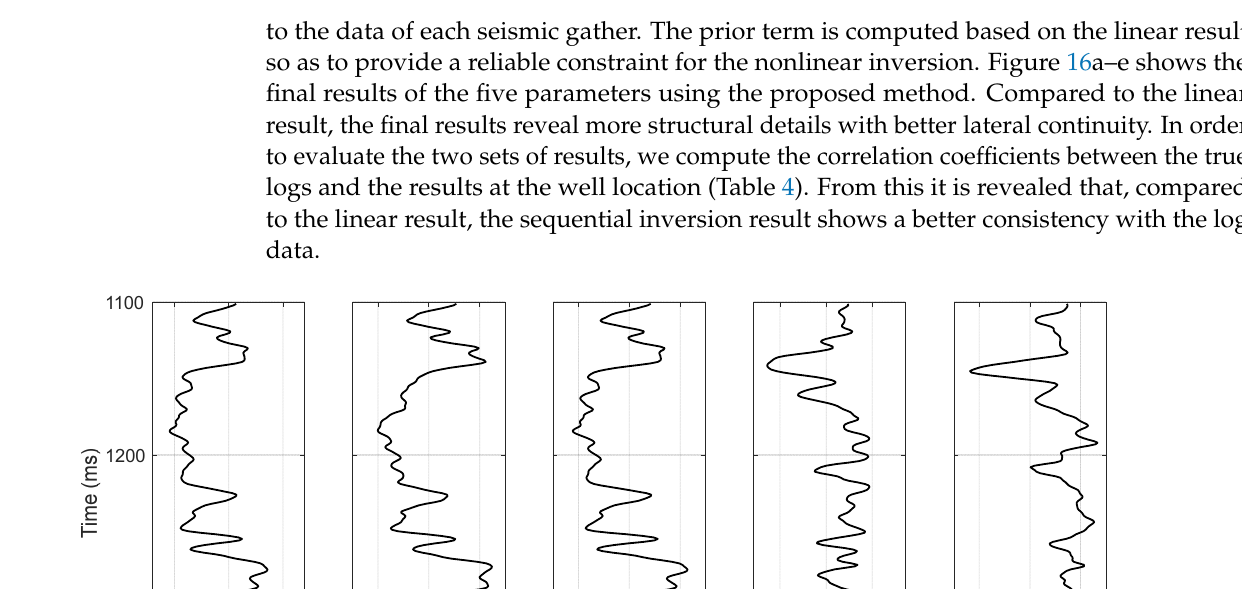
Figure 14. Well logs of the target layer. The panels from left to right give the true values of four sti ff ness parameters of c 33 , c 55 , c 11 , and c 13 , and density ρ .